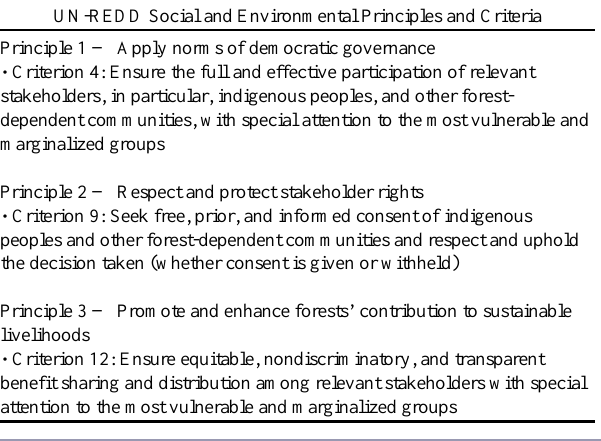
Table 1 . Selected social and environmental principles and criteria guiding the implementation of REDD projects, developed by the UN-REDD Programme